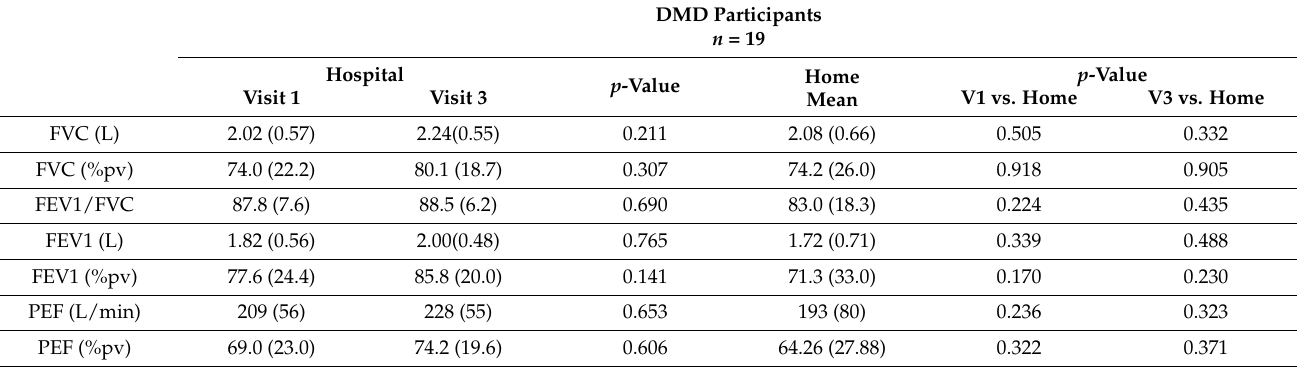
Table 3. Mean values of hospital and home spirometry for study group (Mean ± SD).